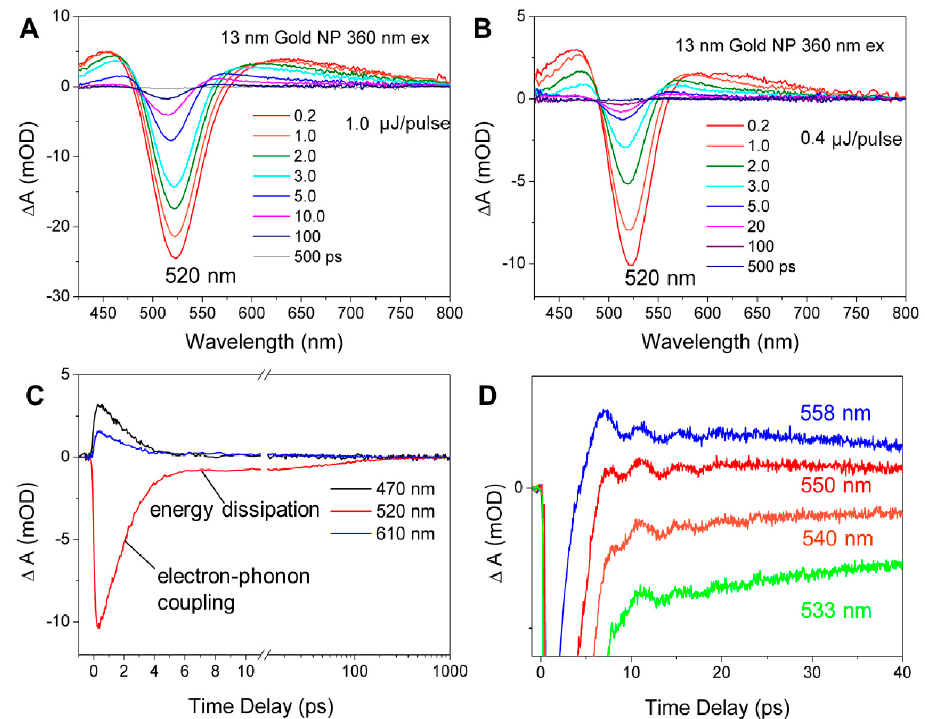
Figure 7. ( A , B ) Transient absorption spectra of 13 nm AuNPs at di ff erent time delays with an excitation of 360 nm under high and low pump fluences; ( C ) TA decay traces at selected probe wavelengths; ( D ) kinetic traces with prominent oscillation features.